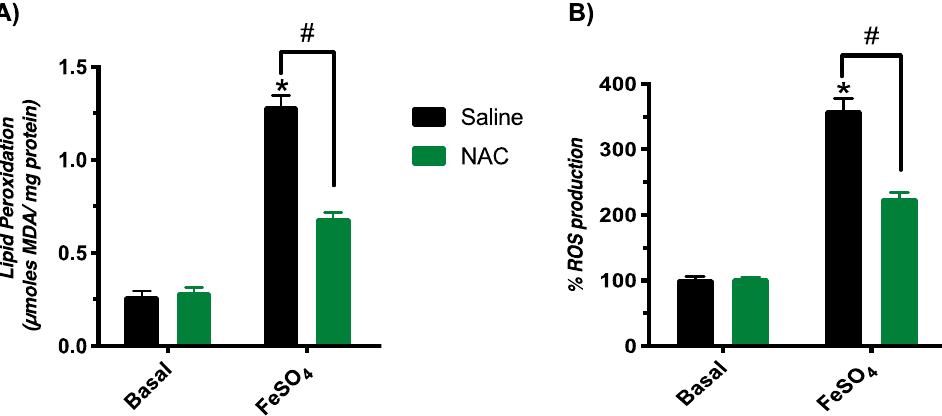
Figure 1. Effect of subchronic NAC administration on brain lipid peroxidation and ROS production induced by the pro-oxidant FeSO 4 in vitro. Brain tissues were obtained from mice treated i.p. with saline or NAC (100 mg/kg/day). See Materials and Methods for experimental details. ( A ) Basal status of lipid peroxidation and effect of FeSO 4 (5 µ M). ( B ) ROS formation, expressed as a percentage of control values, under basal conditions and after exposure to FeSO 4 . Data are the mean ± SEM ( n = 10 for each of the 4 groups). Two-way ANOVA was performed for lipid peroxidation and ROS with pairwise comparisons using Tukey’s adjusted p -values. * p < 0.05 vs. basal saline and # p < 0.05 vs. saline + FeSO 4